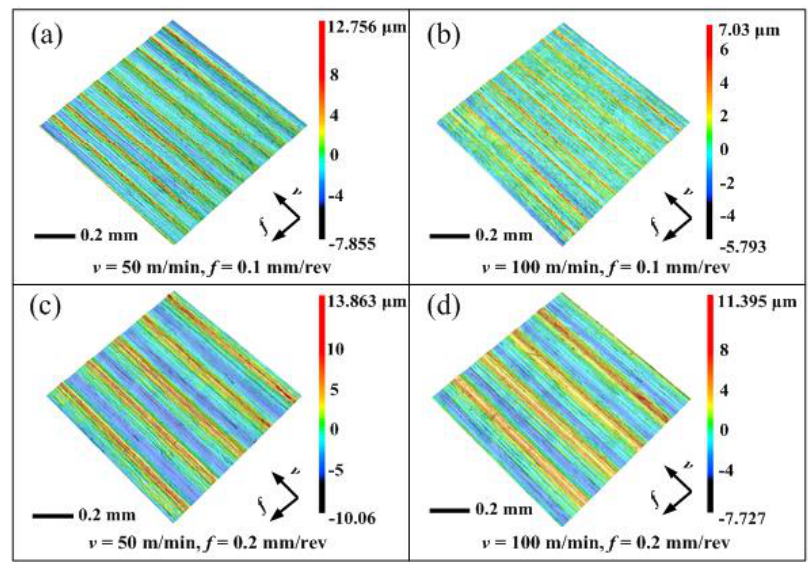
Figure 6. 3D surface topography in cylinder turning, ( a ) v = 50 m/min, f = 0.1 mm/rev; ( b ) v = 100 m/min, f = 0.1 mm/rev; ( c ) v = 50 m/min, f = 0.2 mm/rev; ( d ) v = 100 m/min, f = 0.2 mm/rev.